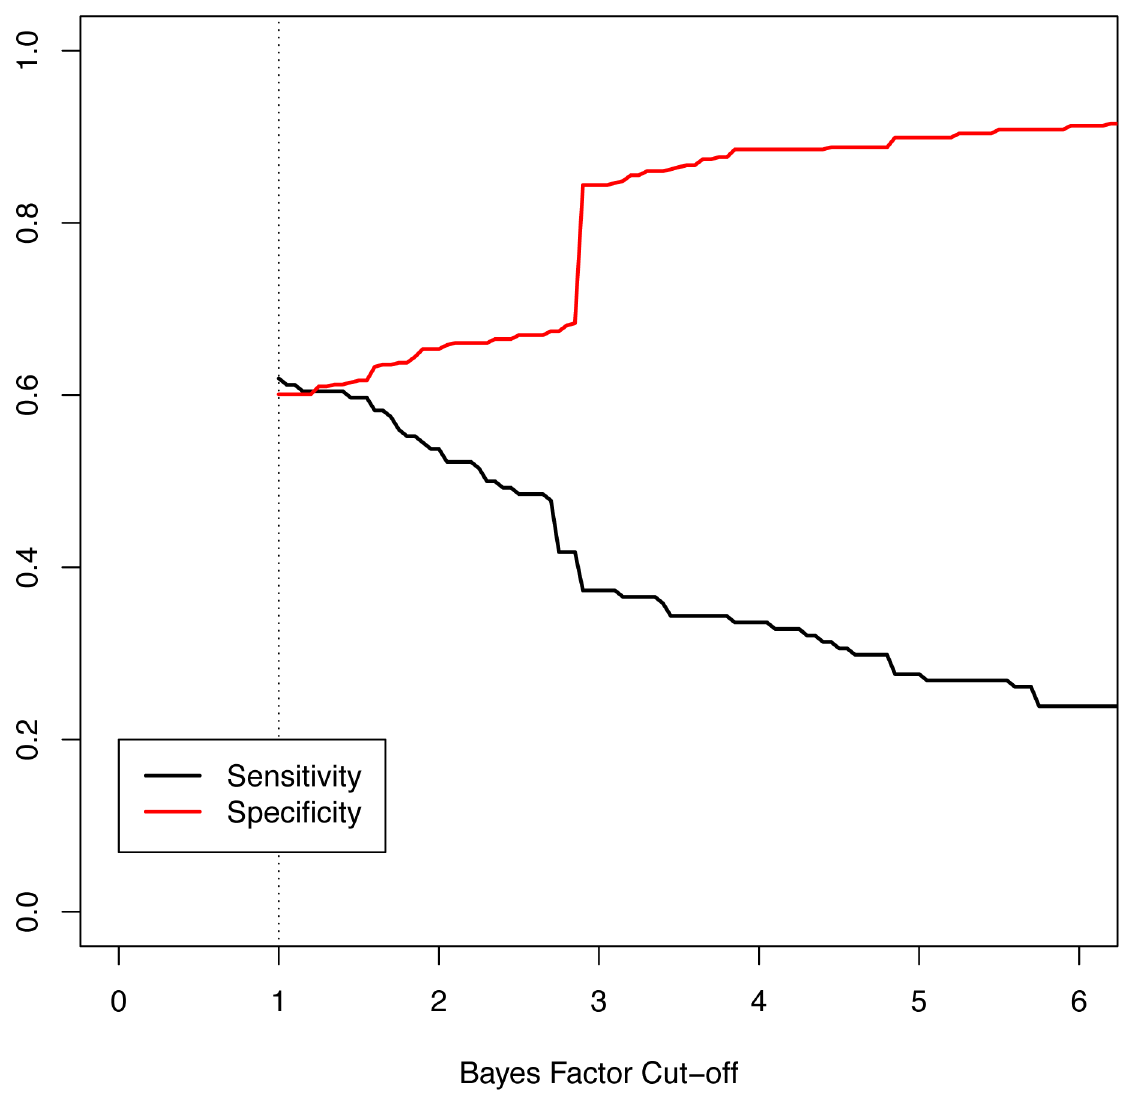
Figure 7. Measures of performance of the Bayes factor to discriminate epilepsy phenotype. The graphic shows the sensitivity and specificity of the Bayes factor to identify patients with epilepsy versus those referred for non-neurologic indications. The sensitivity, or the probability of having a positive test given the phenotype, is shown in black. The specificity, or the probability of a negative test given no phenotype, is shown in red. The minimum Bayes factor for a gene or patient is 1 by definition (dotted line).